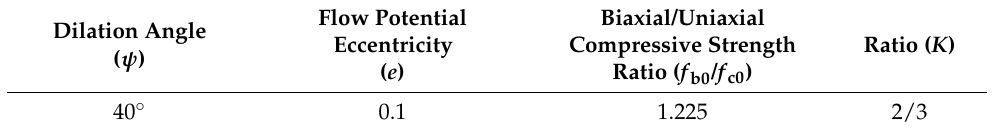
Table 1. Plastic parameters of the concrete damaged plasticity (CDP)